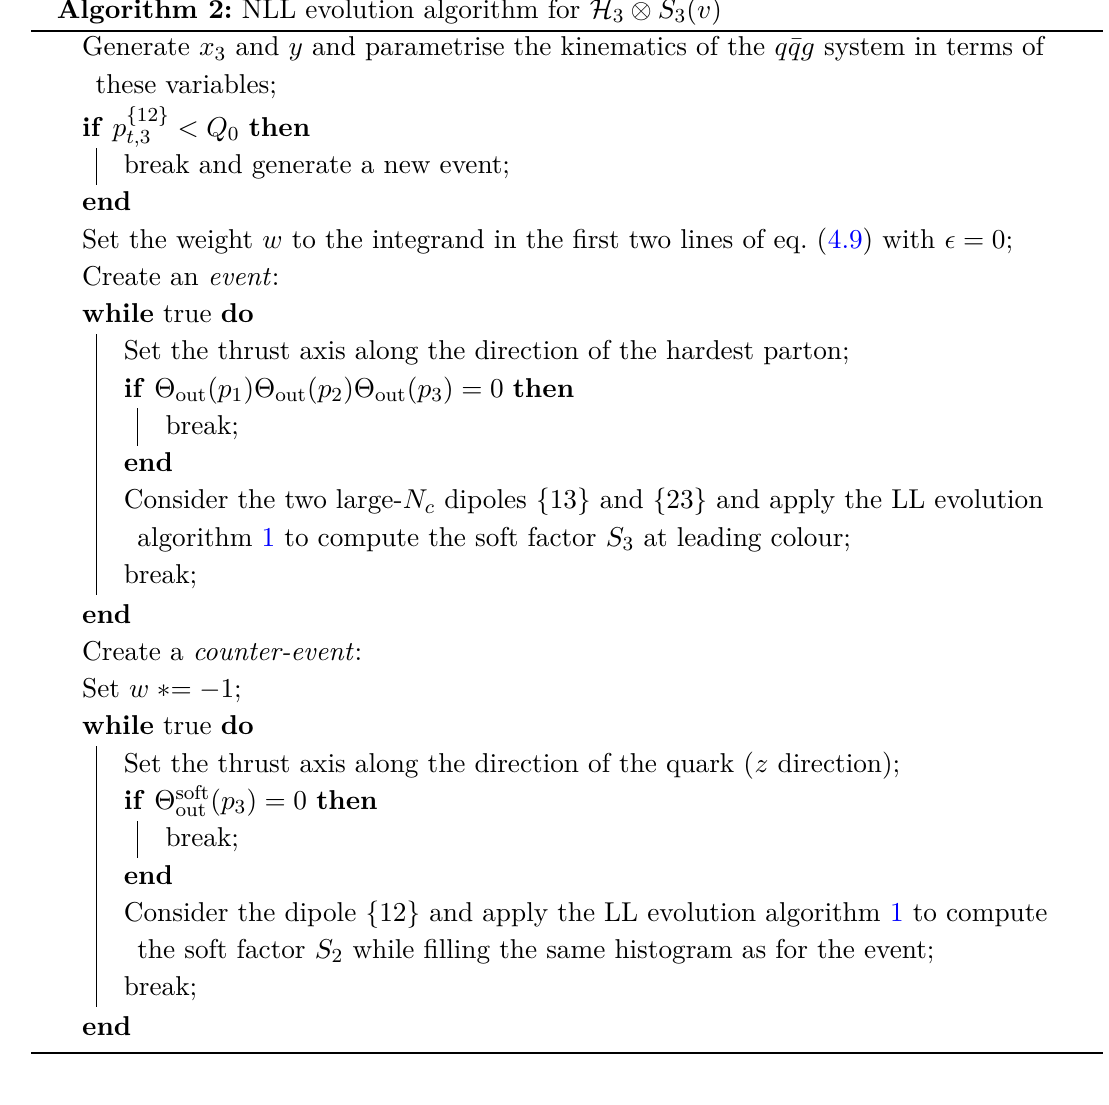
Algorithm 2: NLL evolution algorithm for H